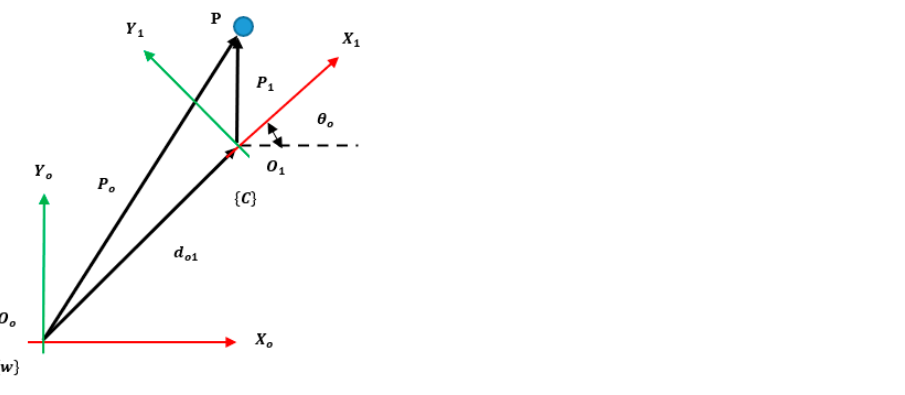
Figure A2. Transformation of Centroid Points P from Camera Frame to Grid World Coordinates.